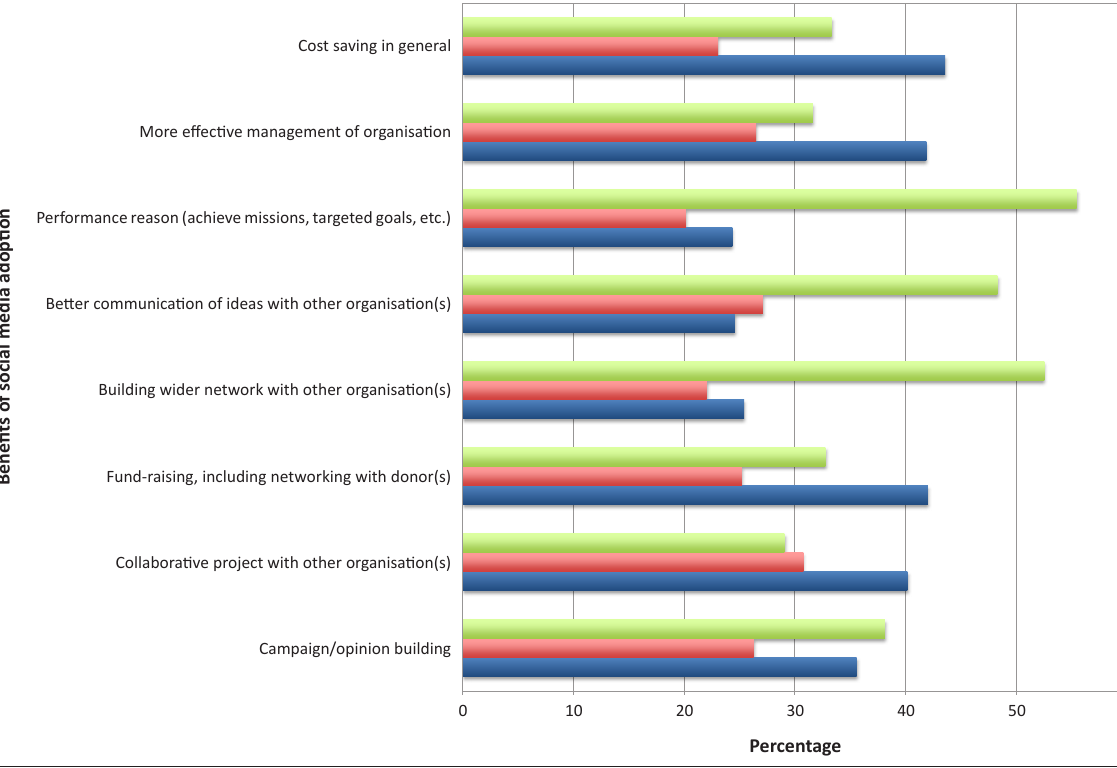
FIGURE 4: Benefits of social media